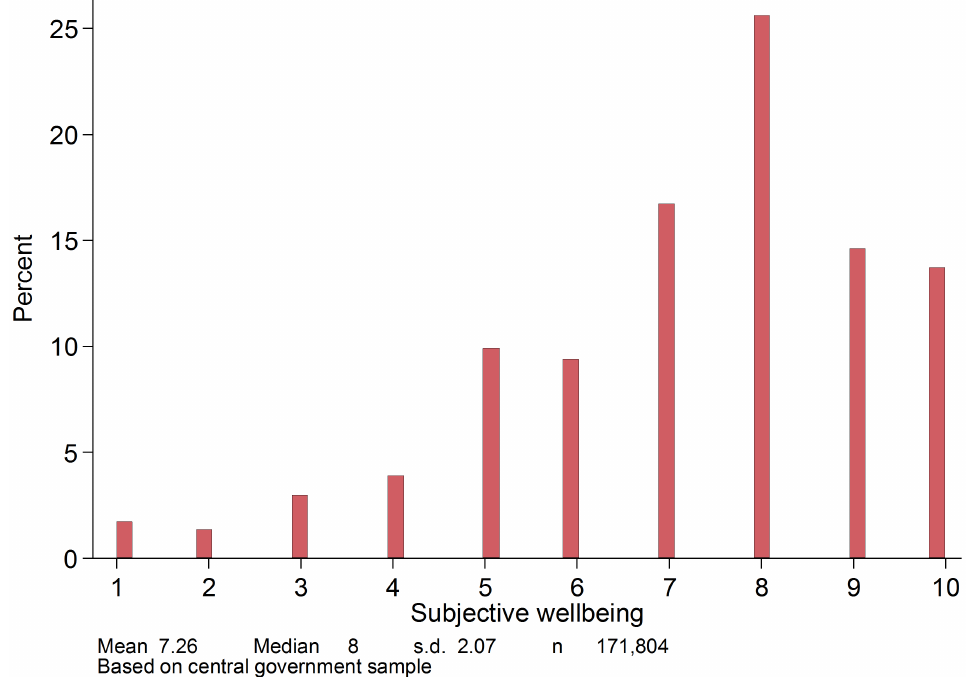
Figure A.2: Histogram of SWB